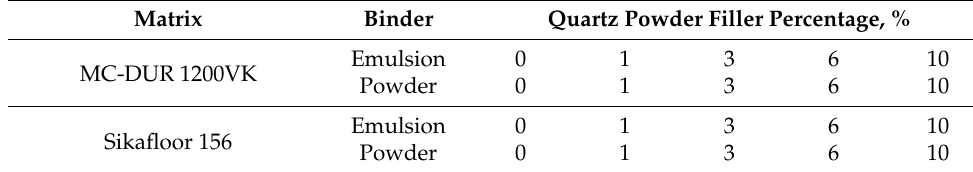
Table 1. The compositions of the tested epoxy resin composite samples. Table 1. The c ompositions of the tested epoxy resin composite samples.